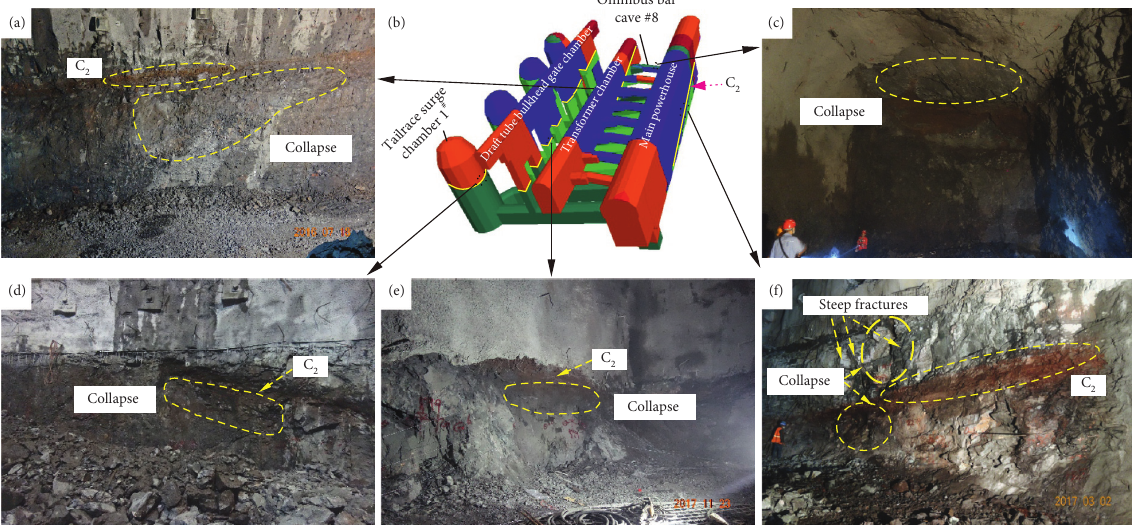
Figure 4: Rock collapses occurred along C 2 in the underground powerhouse: (a) the downstream sidewall of layer IV of the transformer chamber; (b) a schematic diagram of the rock mass collapse position; (c) the crown arch of omnibus bar cave #8; (d) the shaft section of tailrace surge chamber #1; (e) the upstream sidewall of gate shaft #3; (f) the downstream sidewall of layer VI 2 of the main powerhouse section from ZC0 +156m to ZC0